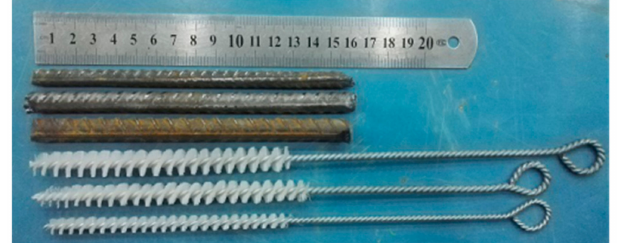
Figure 10. Steel bar for interface